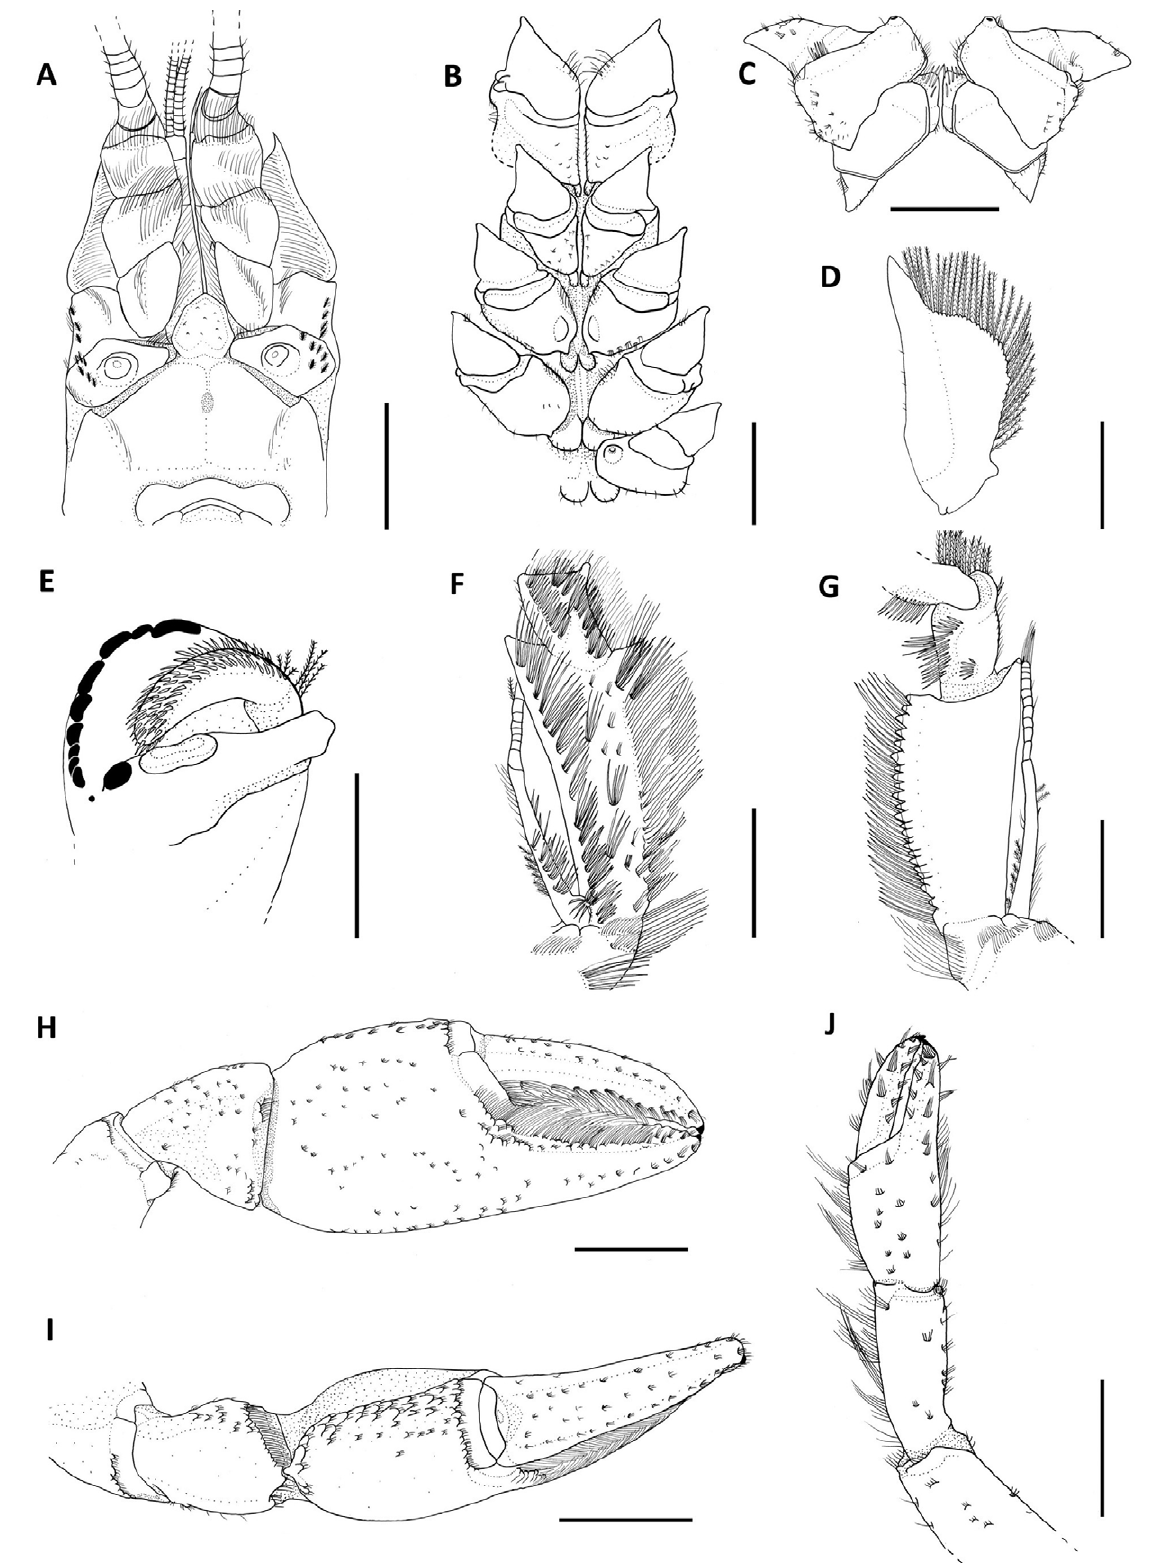
Figure 5. Parastacus pilicarpus sp. nov. A, epistome (holotype); B, thoracic sternites and gonopores (holotype); C, thoracomere 8, caudal view (holotype); D, antennal scale lateral view (paratype 1); E, mandible (paratype 1); F, third maxilliped ventral view (paratype 1); G, third maxilliped dorsal view (paratype 1); H, first pereiopod lateral view (holotype); I, first pereipod dorsal view (holotype); J, second pereiopod lateral view (holotype). Scale bars: A, E – 2.50 mm; B, C, H, J – 5 mm; D – 2.00 mm; F, G, I – 3.33